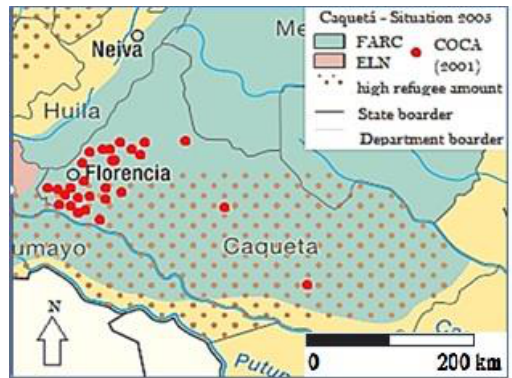
Figure 1. Guerrilla presence and refugee activities (2005) as well as coca production (2001) in Caquetá. Source: reference [33], modified with data from reference [54] (p. 33).